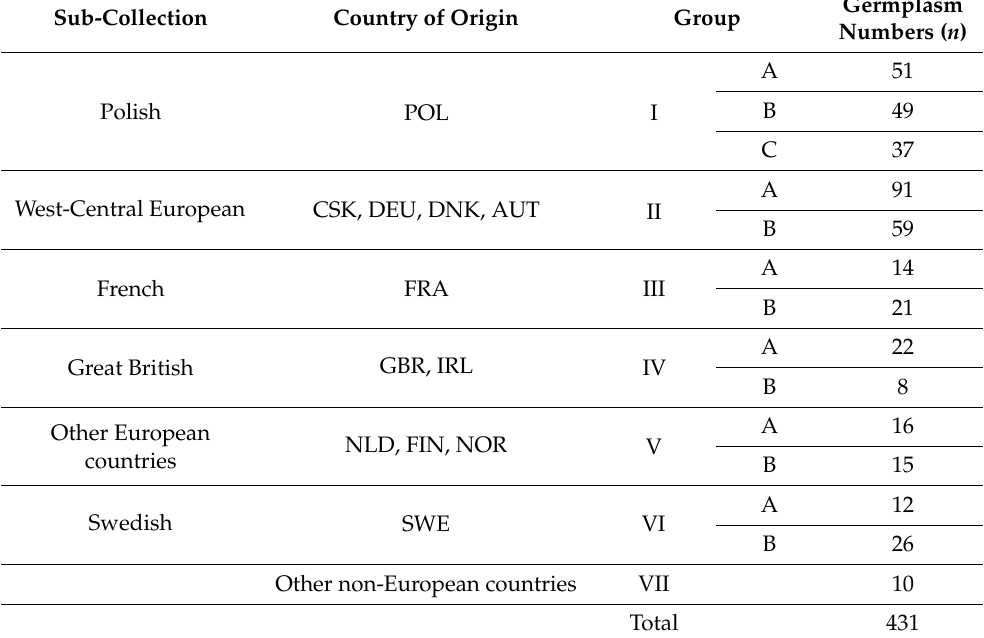
Table 1. Number of accessions per sub-collection and groupings. Group A corresponds to old cultivars cultivated prior to 1985, group B corresponds to moderate and modern cultivars cultivated after 1985, and group C corresponds to Polish